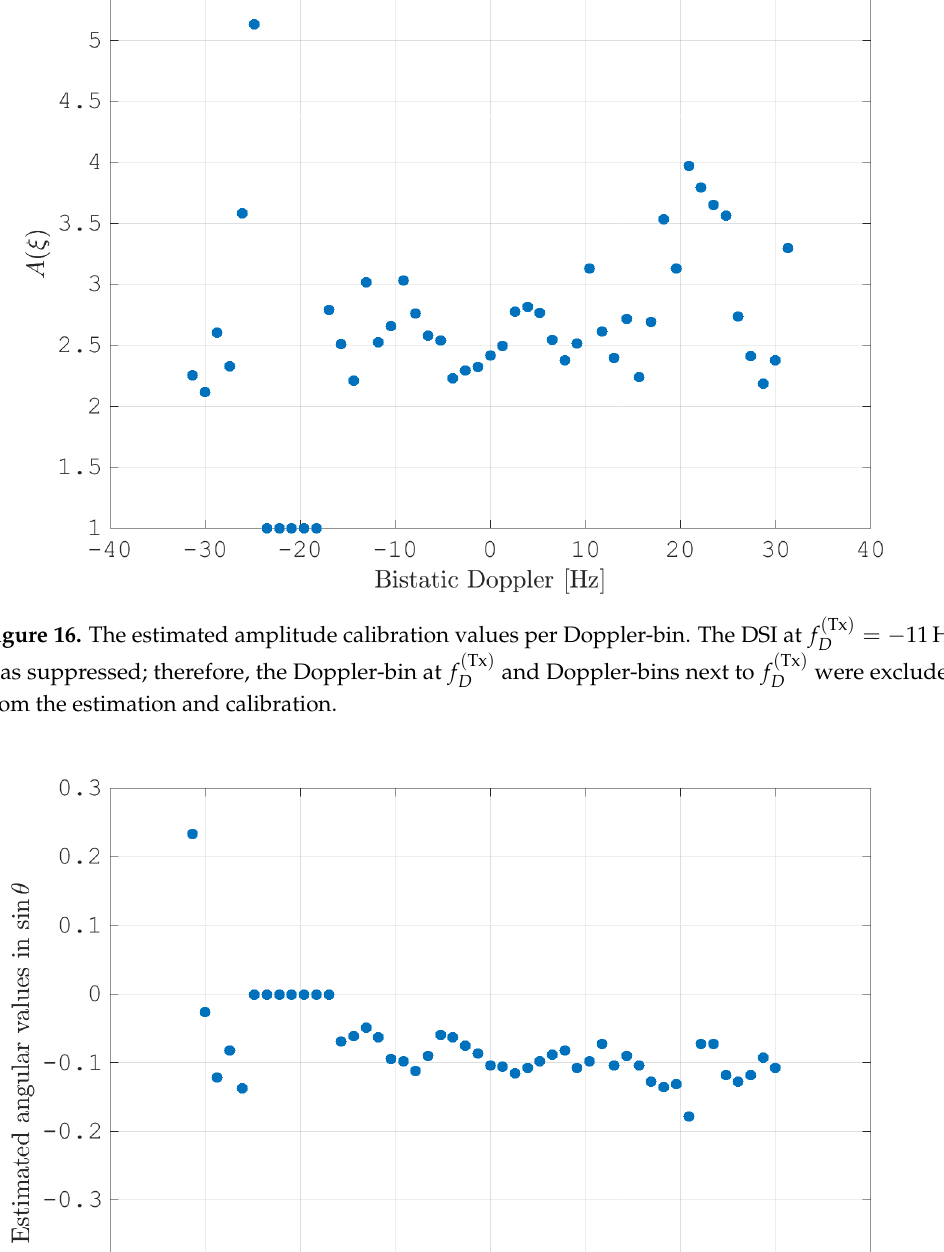
Figure 17. The estimated calibration values for the phase per Doppler-bin. The DSI at f was suppressed; therefore, the Doppler-bin at f from the estimation and